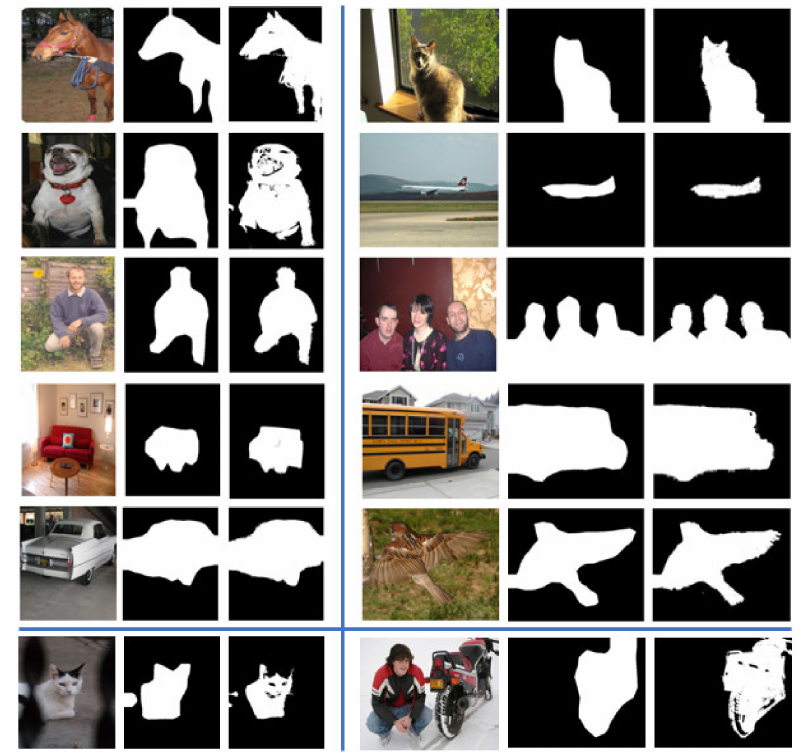
Figure 7. Visualization results on Semantic Boundaries Dataset (SBD)-val. For each row, we show the query image, the segmentation result delivered by the few-shot guided network, and the refined segmentation result of the fully connected CRF. The last row shows failure